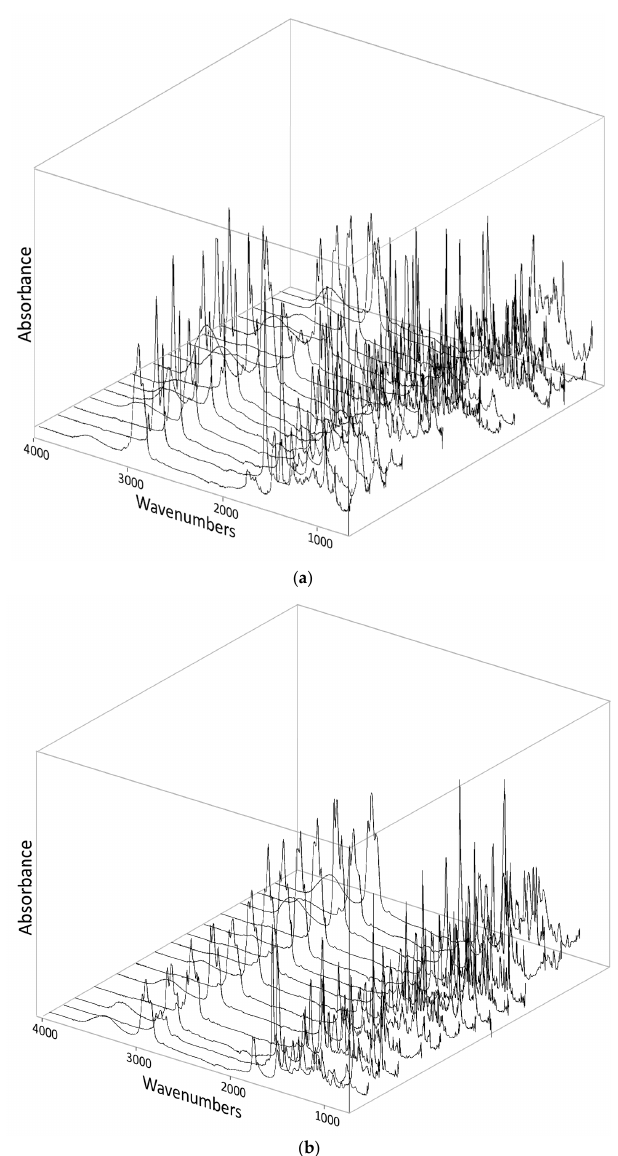
Figure 1. Attenuated total reflection Fourier-transform infrared spectroscopy (ATR-FTIR) superimposed spectra of concentrated essential oil samples ( a ) and commercial-grade essential oils ( b ).